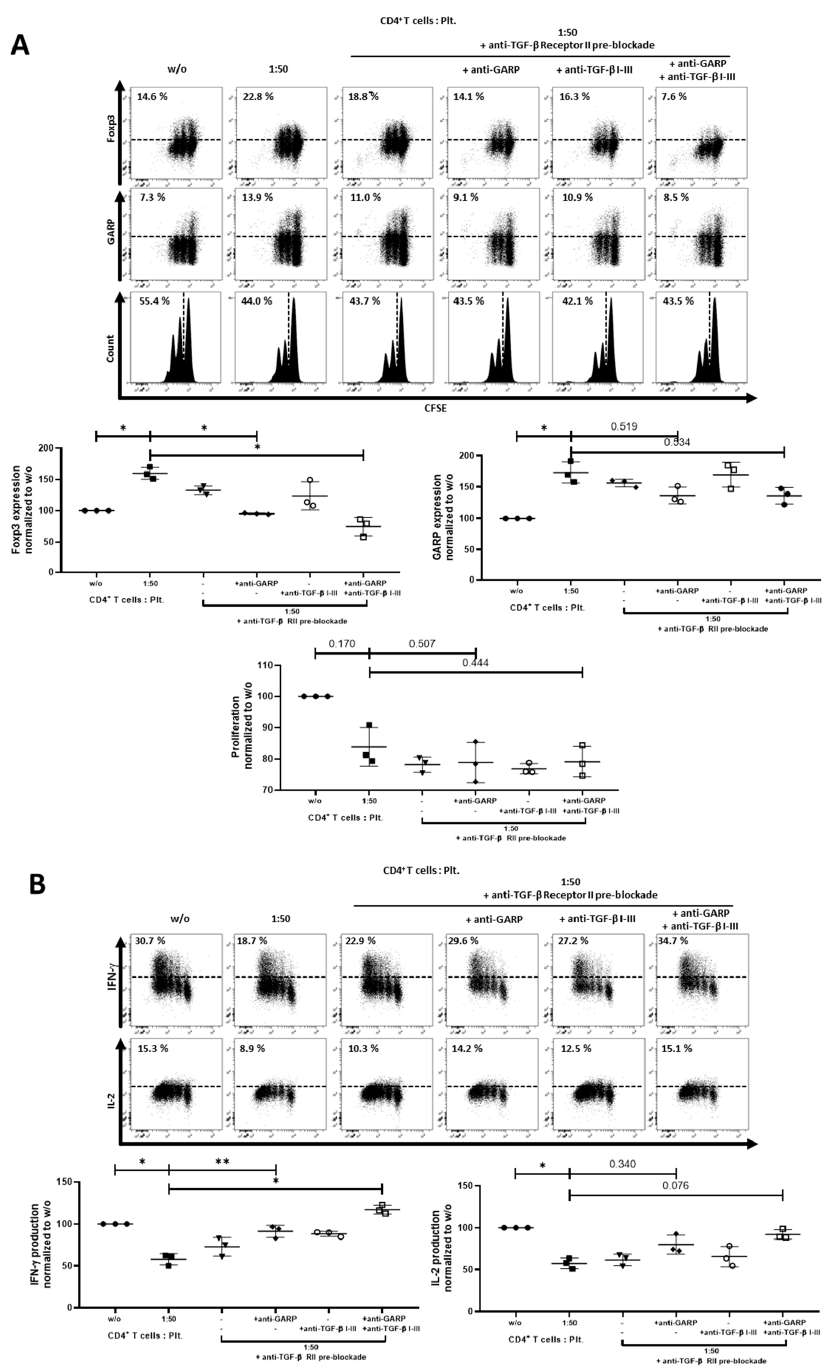
Figure 6. Combining blockade of TGF- β signaling and GARP led to a complete inhibition of platelet e ff ects. ( A ) CFSE-labeled CD4 + CD25 − T cells were cocultured with platelets in the ratio of 1:50 and were stimulated with anti-CD3 mAb (0.5 µ g / mL) and anti-CD28 mAb (1.0 µ g / mL). CD4 + CD25 − T cells were incubated for 15 min with TGF- β receptor II (10 µ g / mL) antibody prior to coculture, as indicated. Excess antibody was removed. Pre-treated CD4 + CD25 − T cells were cultured in the presence of either anti-TGF- β I–III (10 µ g / mL) and / or anti-GARP Ab (10 µ g / mL) antibodies. Antibodies were added at day 0. The expression of Foxp3, GARP and cell proliferation were determined on day 3 via flow cytometry. ( B ) Production of IL-2 and IFN- γ was assessed by intracellular flow cytometry on day 6. The graphs show cells cultured in the presence of platelets normalized to CD4 + CD25 − T cells without platelets. Dot plots show 1 representative result of 10 independent experiments ( n = 3, means ± SD, * p < 0.05, ** p ≤ 0.01, and n.s. determined by one-way